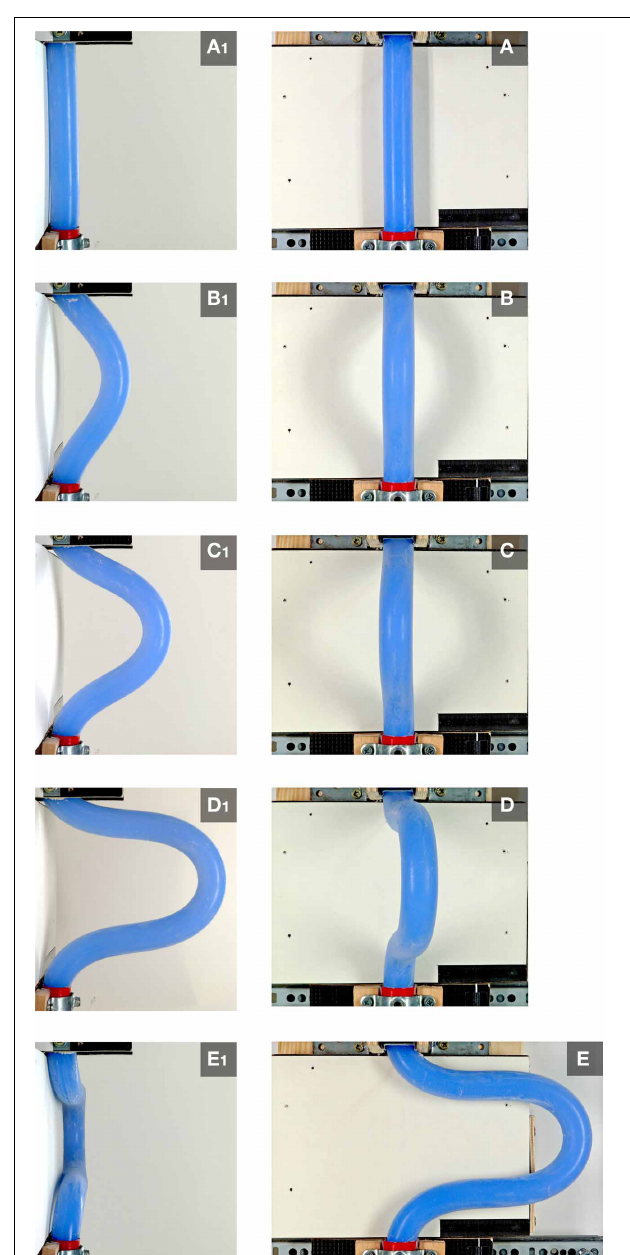
FIGURE 8 | These photographs, taken at frontal (A–E) and right-lateral views (A1–E1), document the buckling behavior of the continuously elongating “intra-pericardial” portion of the silicone rod in the absence of the hemispherical plastic bowl. Under this condition, sinusoidal buckling did not switch to helical buckling. Sinusoidal buckling continued until the configuration became unstable under the rods’ own weight and the curved loop flapped either to the left (E,E1) or right